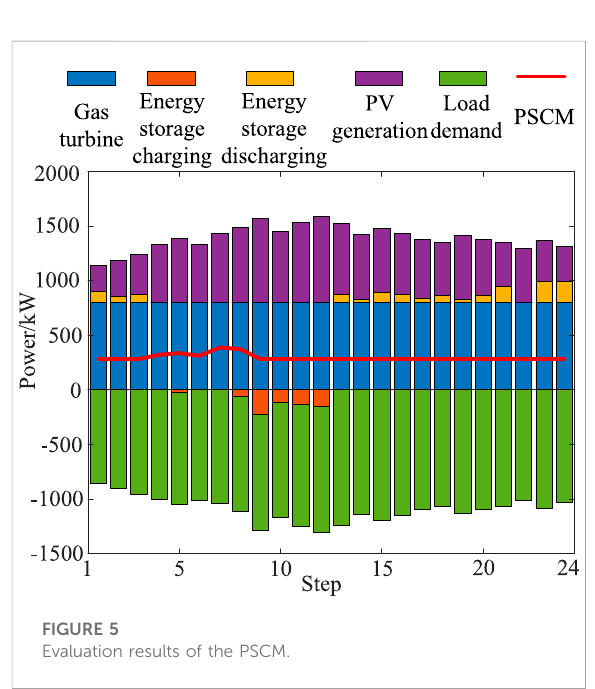
FIGURE 5 Evaluation results of the PSCM.